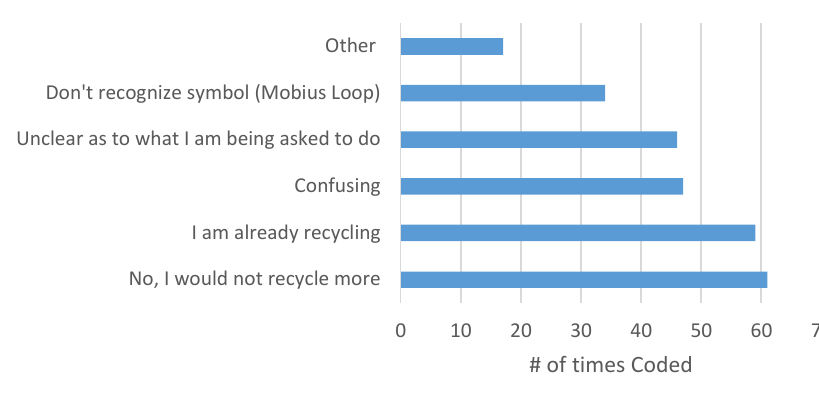
Figure 14. Sample Web Page #1 (Peel Region).